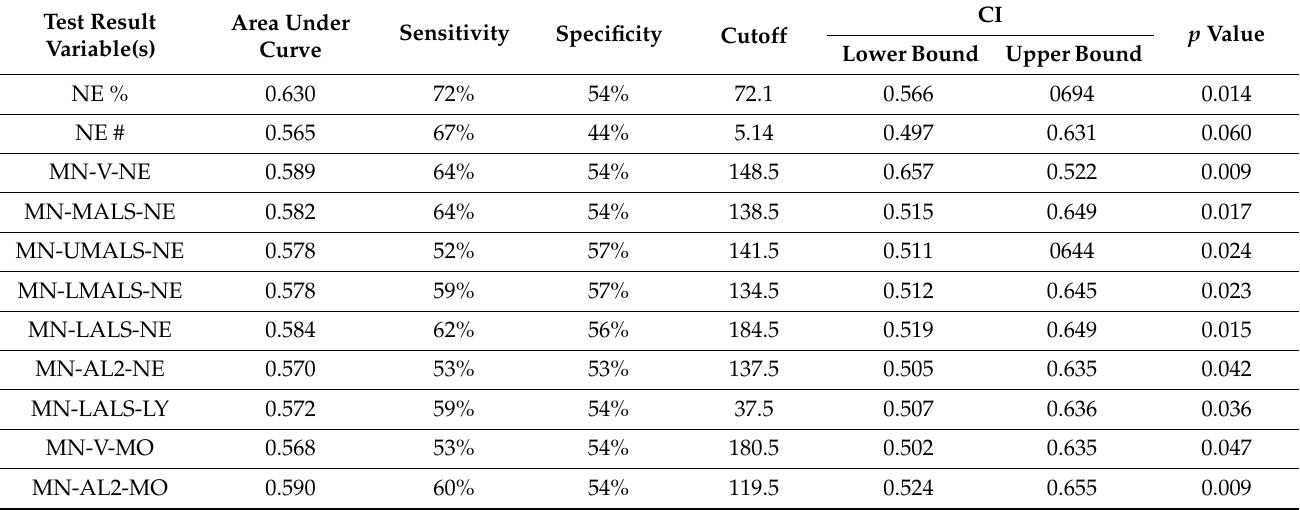
Figure 2. ROC curve for COVID-19 against non-COVID-19 Influenza-like illnesses.